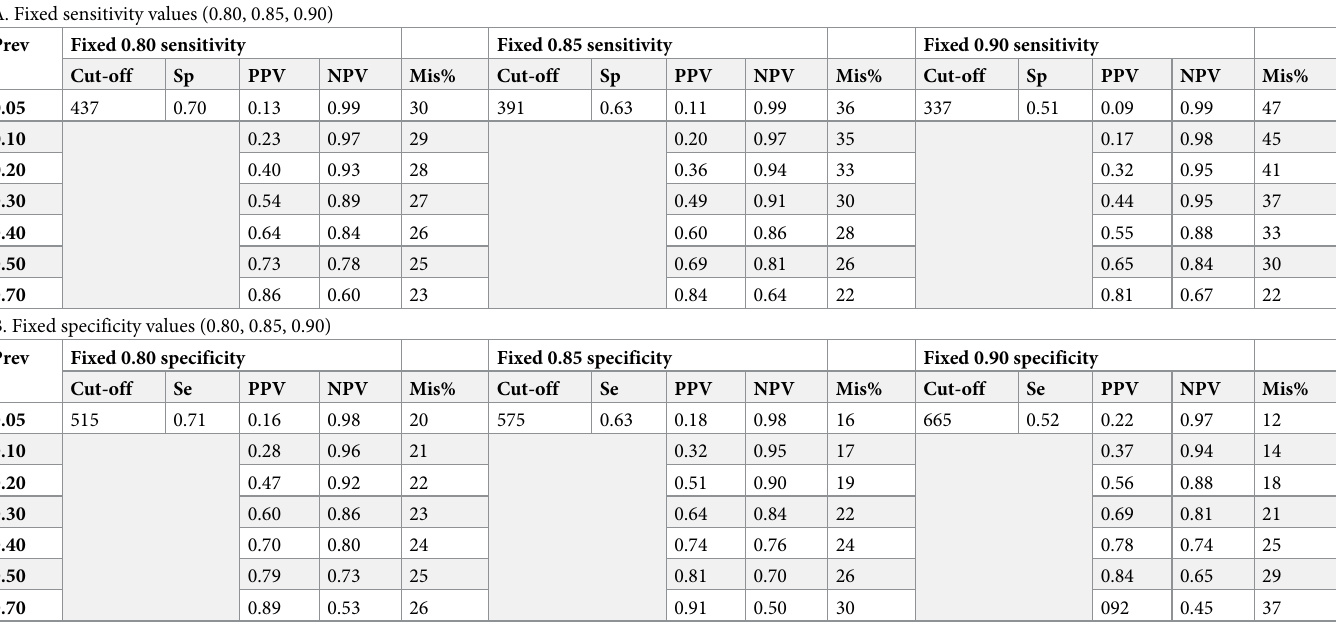
Table 3. Performance of M65 in detecting NASH: Positive and negative predictive values for different settings of NASH prevalence.